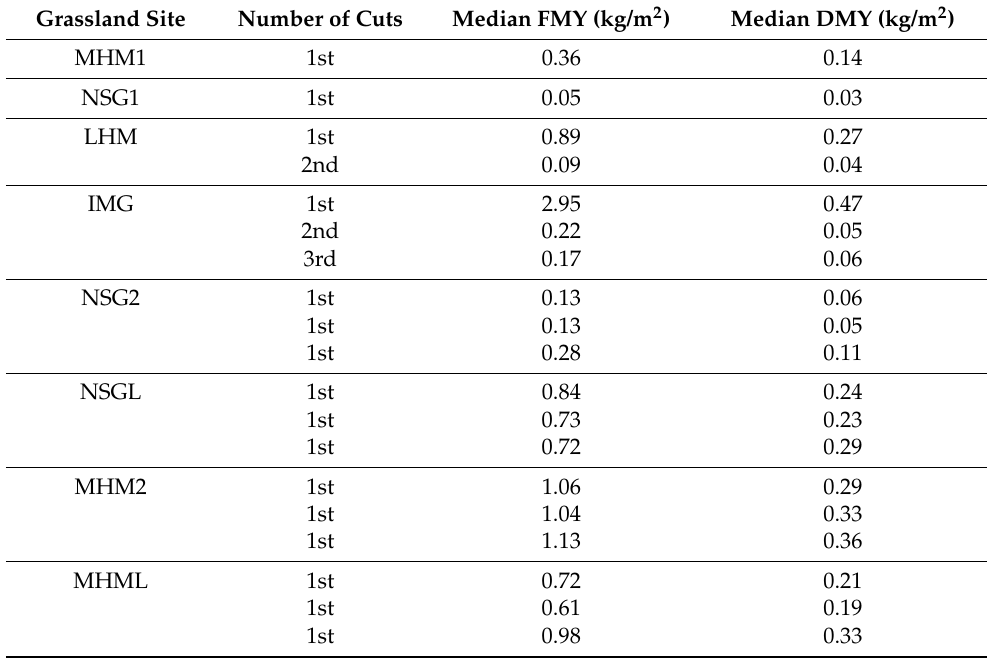
Table A1. Median FMY and DMY biomass yield per cutting date. At grassland sites NGS2, NSGL, MHM2 and MHML different areas of the plot were cut at three sampling dates, resulting in differing dates for the first